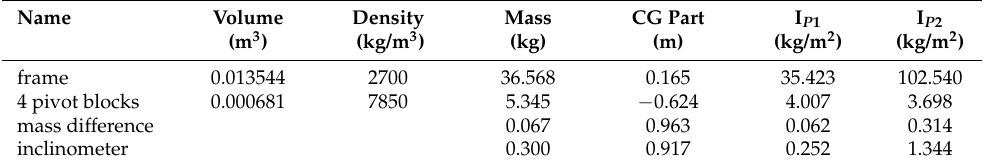
Figure 1. Overview of the swing with support structure (1), swing (2), inclinometer (3) and masses including the rope highlighted with a red line (4) as well as the two different pivot axis (P1 and P2): ( a ) Balanced swing at the pivot axis P1. ( b , c ) Swing at the pivot axis P2 with full calibration weights ( d ) Support structure moved to remove the swing. Table 1. Properties of the two parts of the swing—Frame includes the red and blue elements shown in Figure 2 and the four pivot blocks are shown in green—the reference for the distance to the centre of gravity (CG) is the height P1. Moment of inertia I is based on theoretical